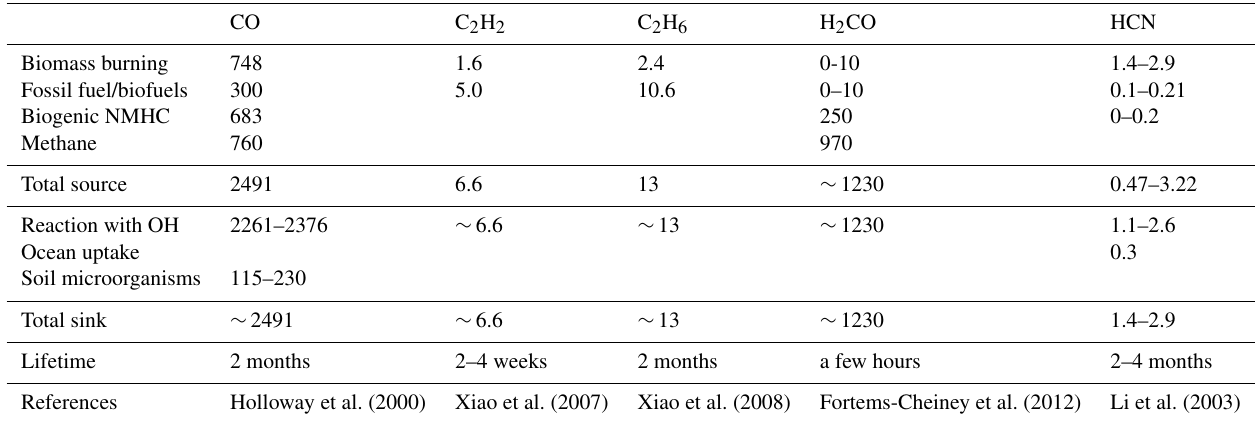
Table 1. Global sources and sinks of atmospheric CO, C 2 H 2 , C 2 H 6 , H 2 CO, and HCN (Tgyr − 1 ). Blank spaces indicate when the source or sink from that component is negligible.